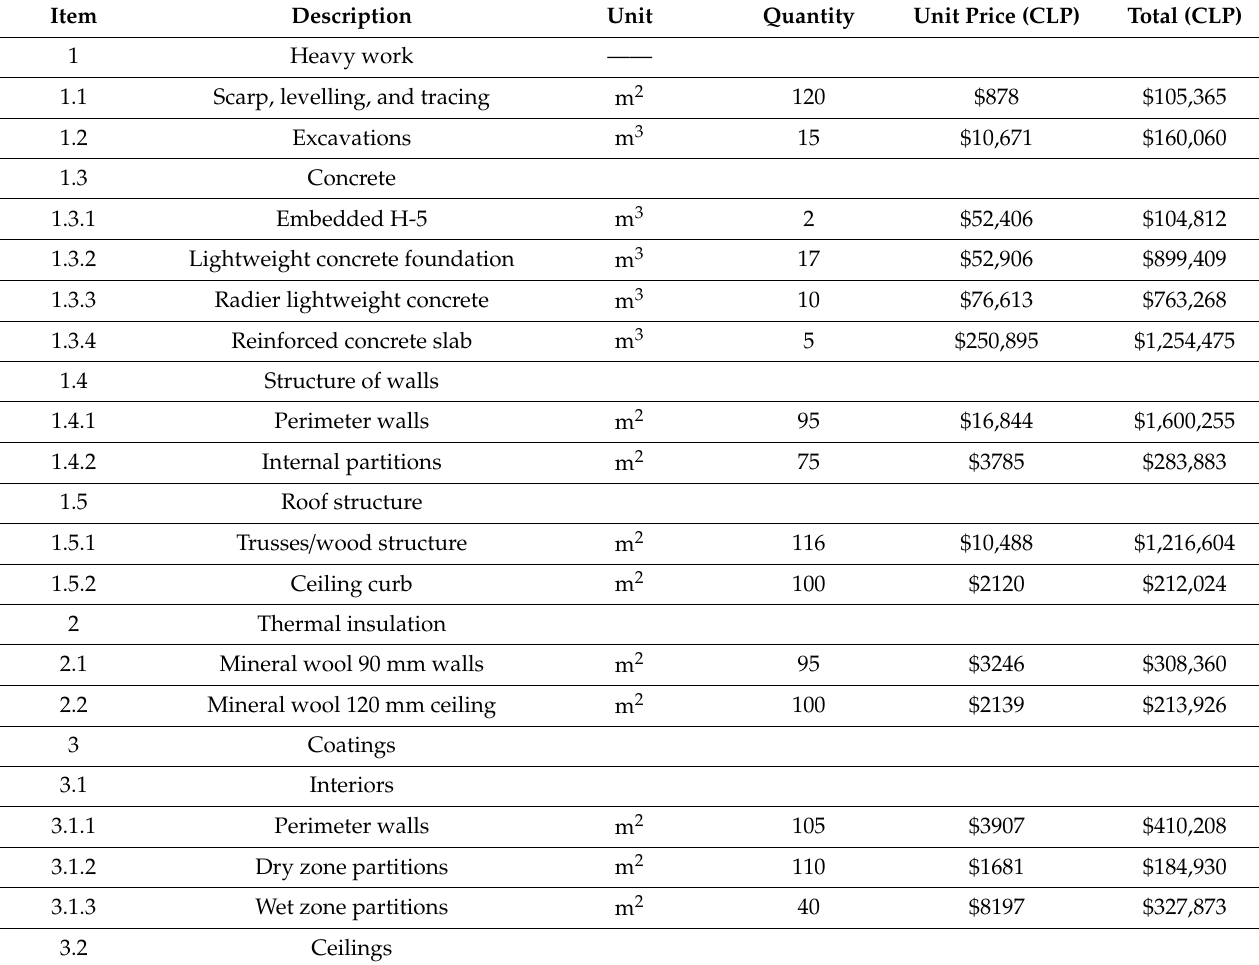
Table A3. Detailed Budget. Traditional